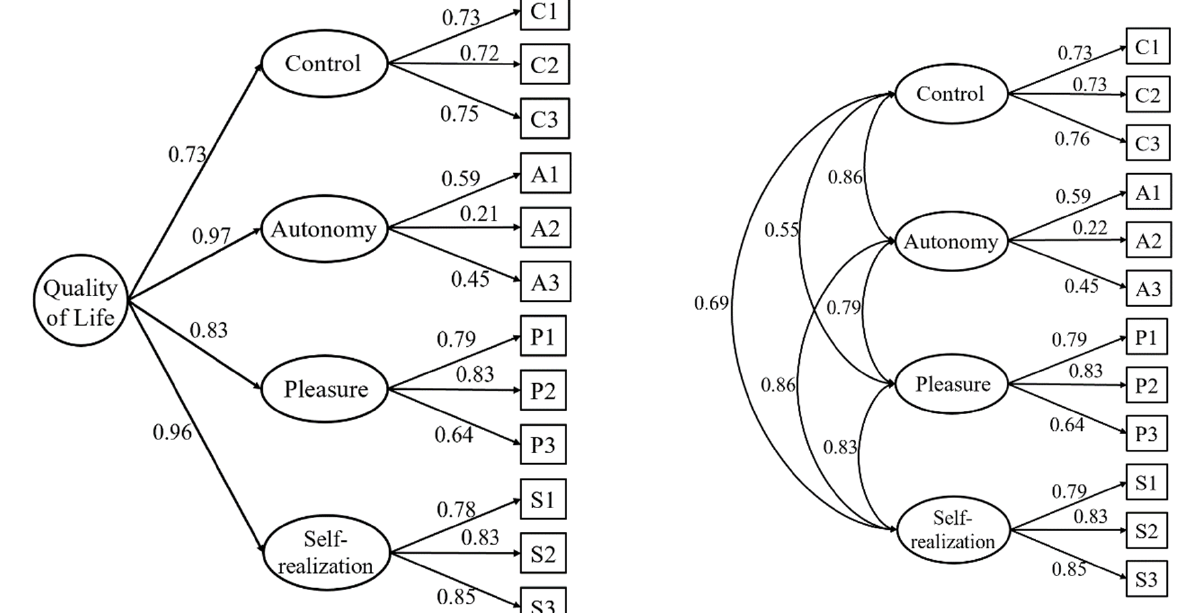
Figure 1. Standardized factor loadings for the retained model. Note: all estimates p < 0.01.